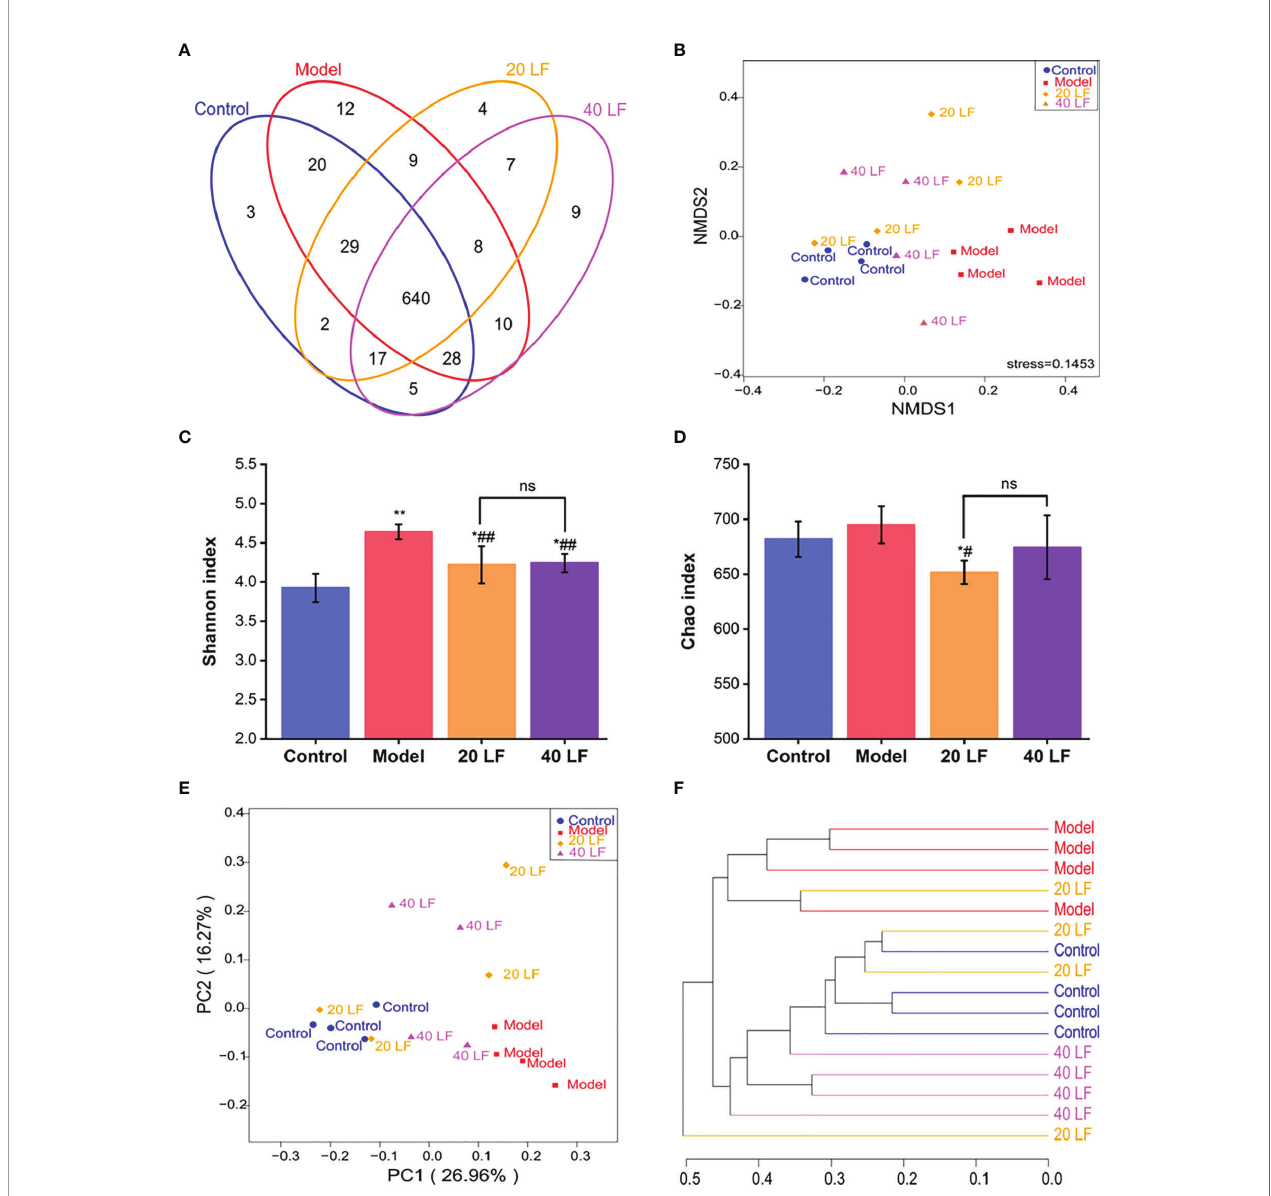
FIGURE 5 | Effects of LF treatment on the gut microbiota composition of the CTX-induced mice ( n = 4). (A) Venn diagrams. (B) Non-metric multi-dimensional scaling (NMDS) analysis. (C) Shannon indices. (D) Chao indices. (E) Principal coordinates analysis. (F) Cluster tree analysis based on the unweighted UniFrac at the genus level. * P < 0.05, ** P < 0.01 vs control; # P < 0.05, ## P < 0.01 vs model, and ns means no signi fi cant